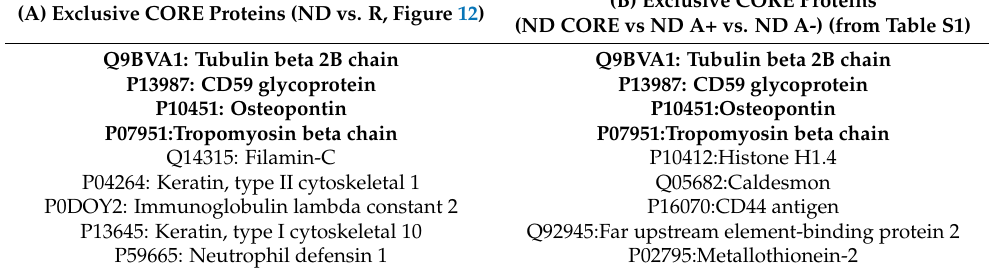
Table 7. Lists in comparison of the nine proteins exclusive of ND GBM CORE with regards to R GBM CORE (column A) and of the nine proteins exclusive of ND GBM CORE with regards to ND GBM CUSA A+ and CUSA A- (column